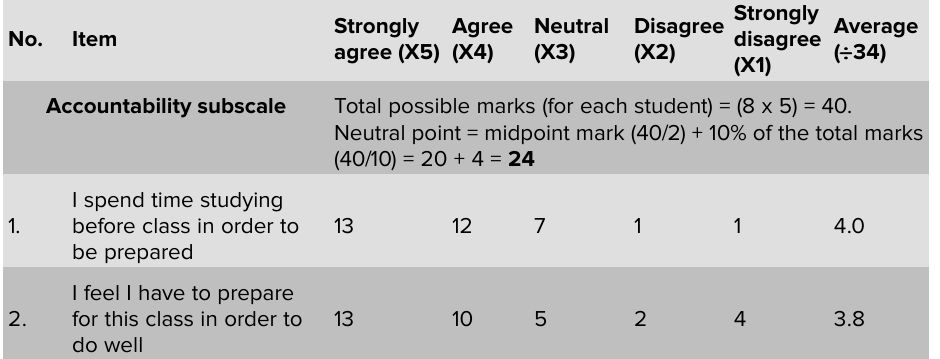
TABLE 2: Detailed students’ responses to the TBL-SAI ( N =